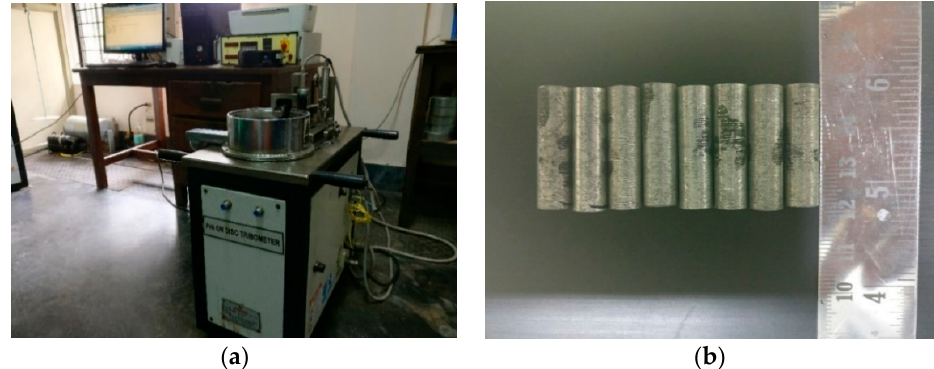
Figure 2. ( a ) Pin-on-disc tribometer used in this study and ( b ) a set of wear test specimens prepared as per ASTM G-99 standards.